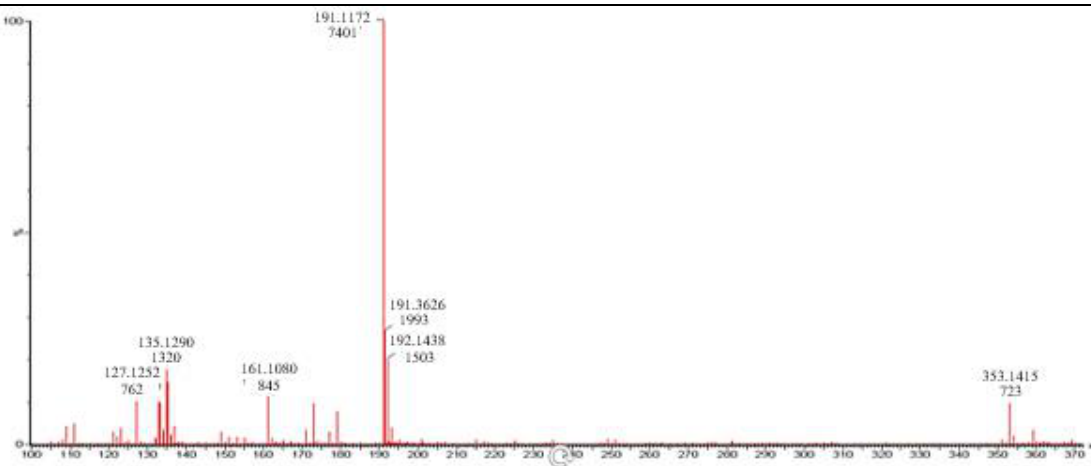
Figure 7.The spectrum of CGA standard. Negative ion mode of Time-of-flight mass spectrometry electrospray ionization (TOF MS ESI-). Ion fragmentation m/z